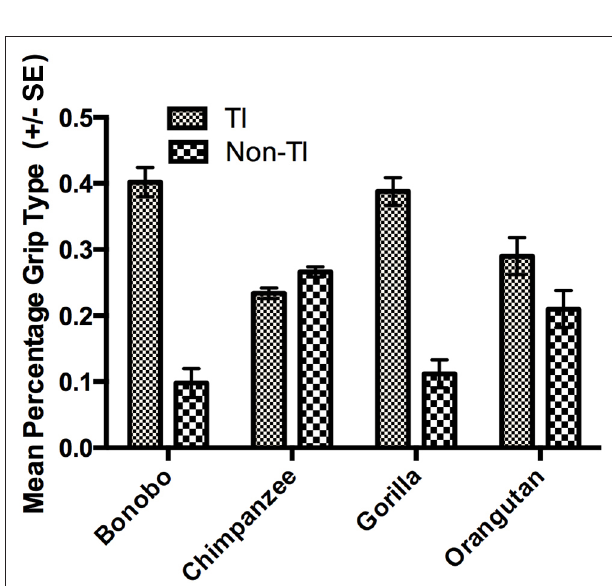
FIGURE 2 | Mean percentage of TI and Non-TI grips ( (cid:6) SE) for each species.